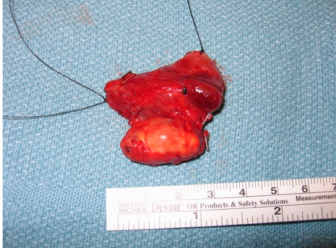
Figure 2. Intraoperative exposure of parathyroid cancer.